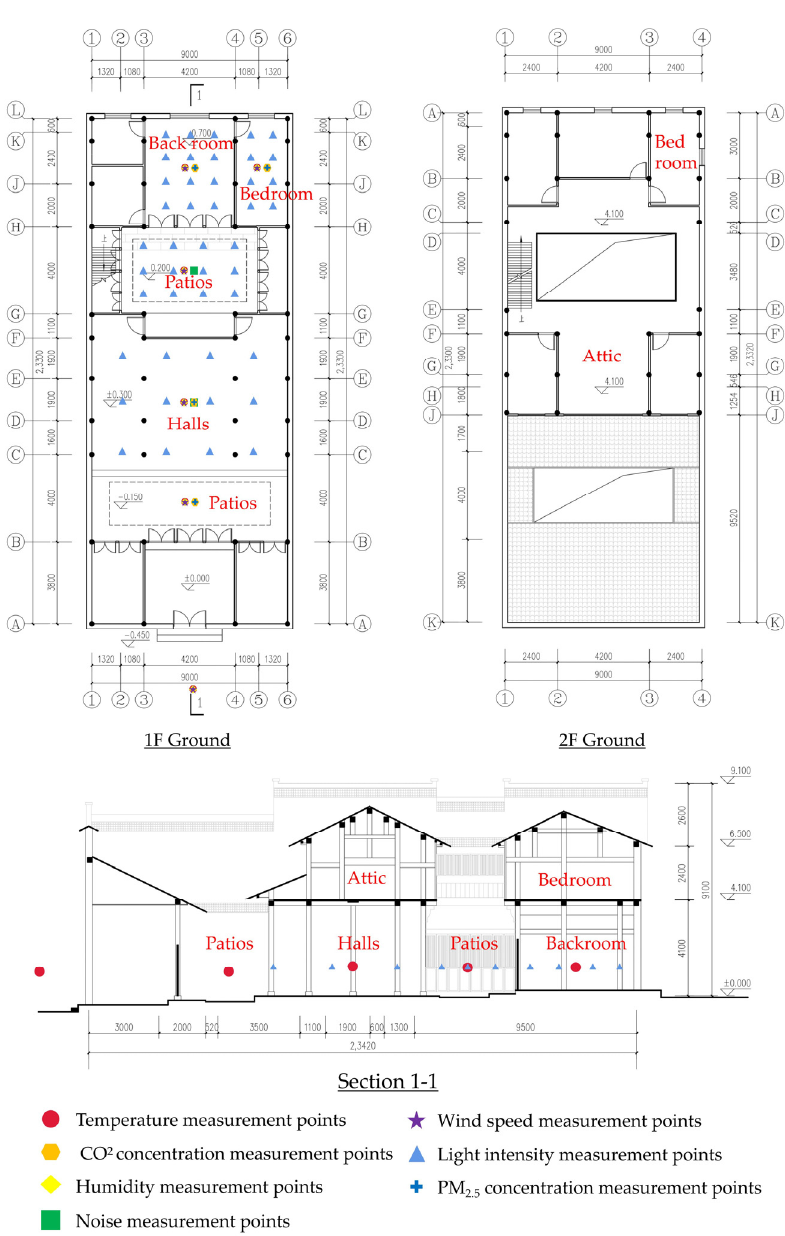
Figure 6. The layout of the “Yao’s House” and the location of the monitoring points.